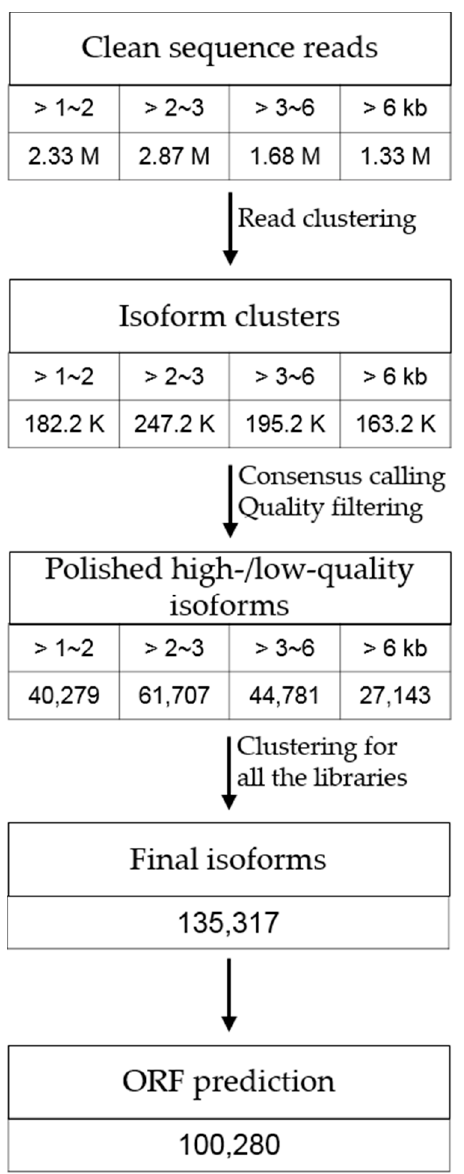
Figure 1. Procedure of transcript assembly of Panax ginseng using Iso-Seq. Sub-reads were merged from 163,195 to 247,189 isoform clusters and classified as full-length (FL) and/or non-FL reads. After consensus sequence calling and quality filtration were performed, sequences were finally clustered into 135,317 isoforms. Open reading frames (ORFs) were also predicted in those unigenes.